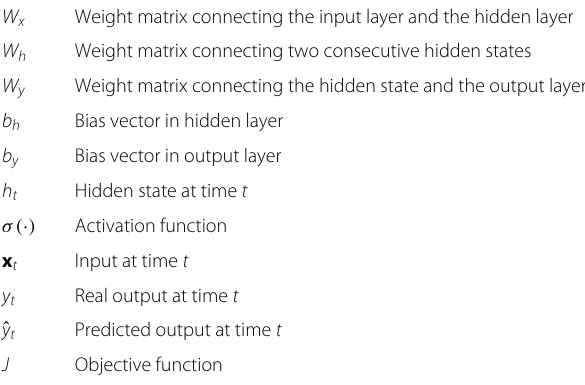
Table 1 Summary of notations